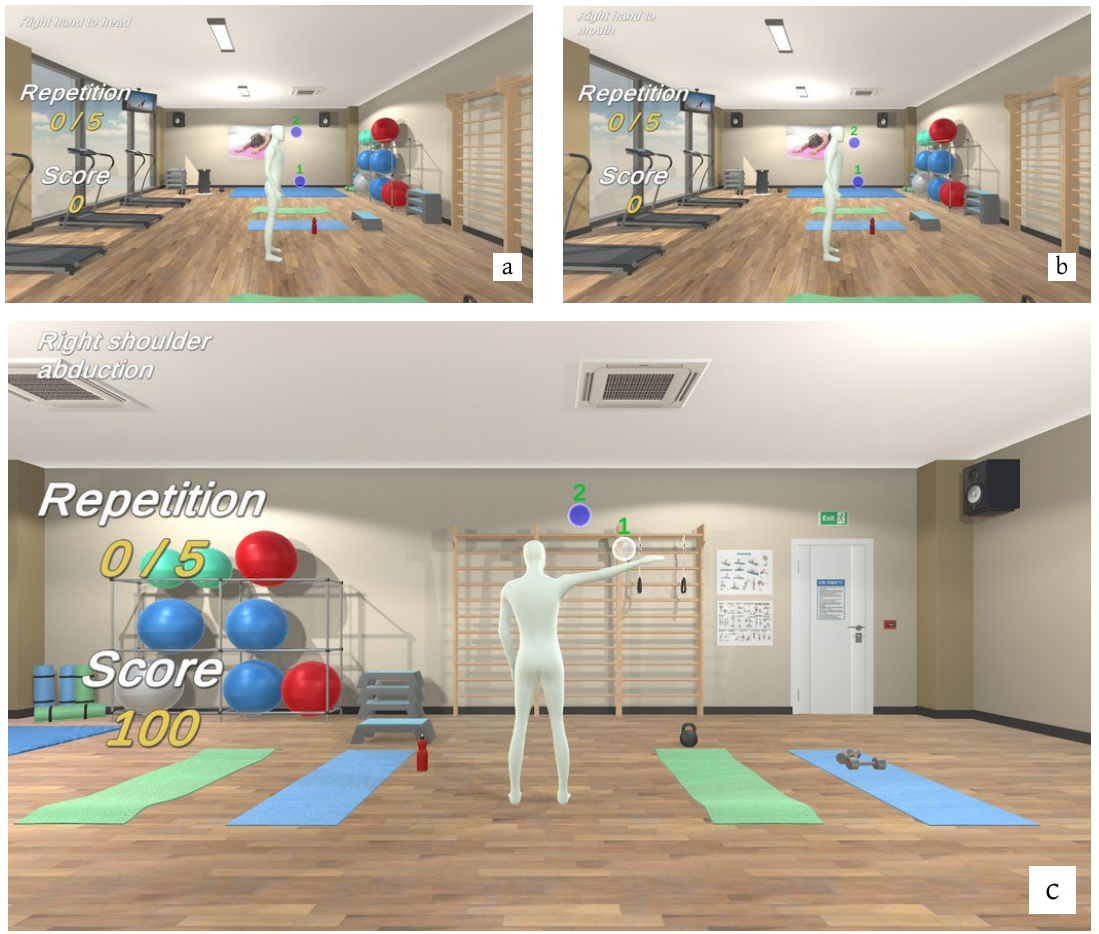
Figure 5. Visual aspect of the generated exergames. ( a ) Right hand to head, ( b ) right hand to mouth, and ( c ) right shoulder